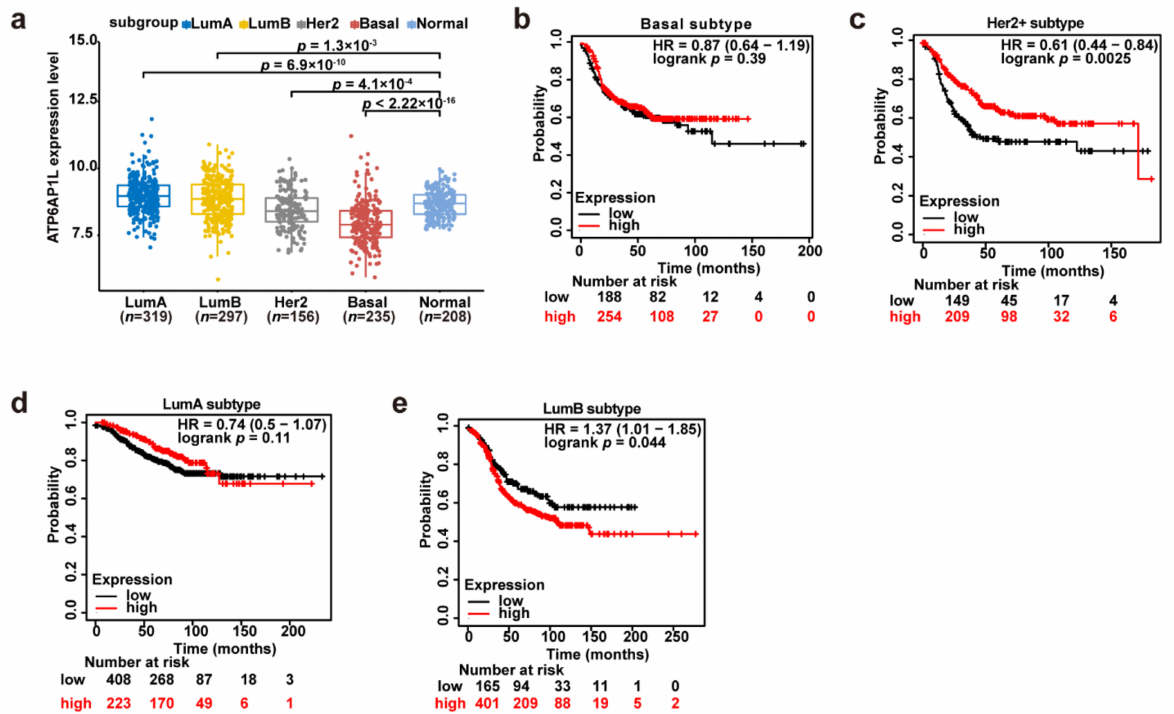
Figure 4. Association between ATP6AP1L expression and breast cancer risk. ( a ) The ATP6AP1L mRNA expression level was analyzed in different subgroups of breast cancer in TCGA cohorts. The p values were examined by Mann–Whitney U tests. ( b – e ) Kaplan–Meier plots examining the risk of ATP6AP1L for recurrence-free survival in different subtype breast cancer were performed by the Kaplan–Meier plotter online in 2032 BRCA patients. The p values were calculated by a log-rank